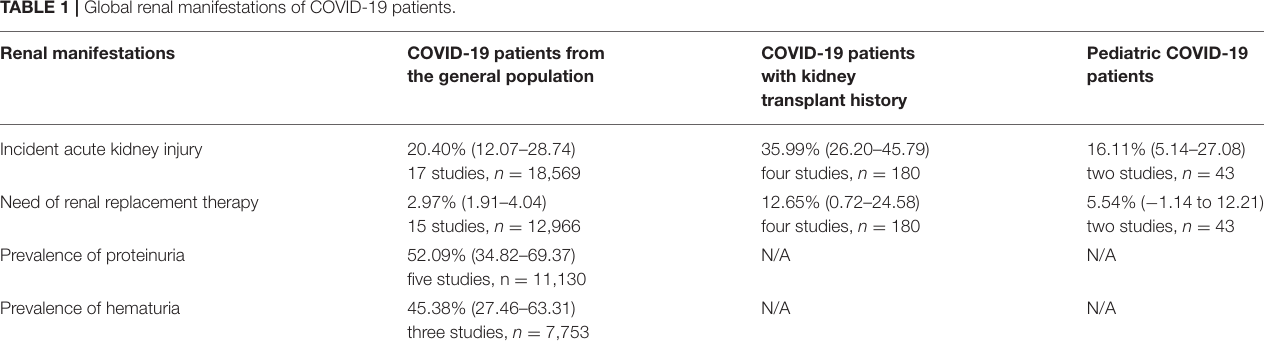
TABLE 1 | Global renal manifestations of COVID-19